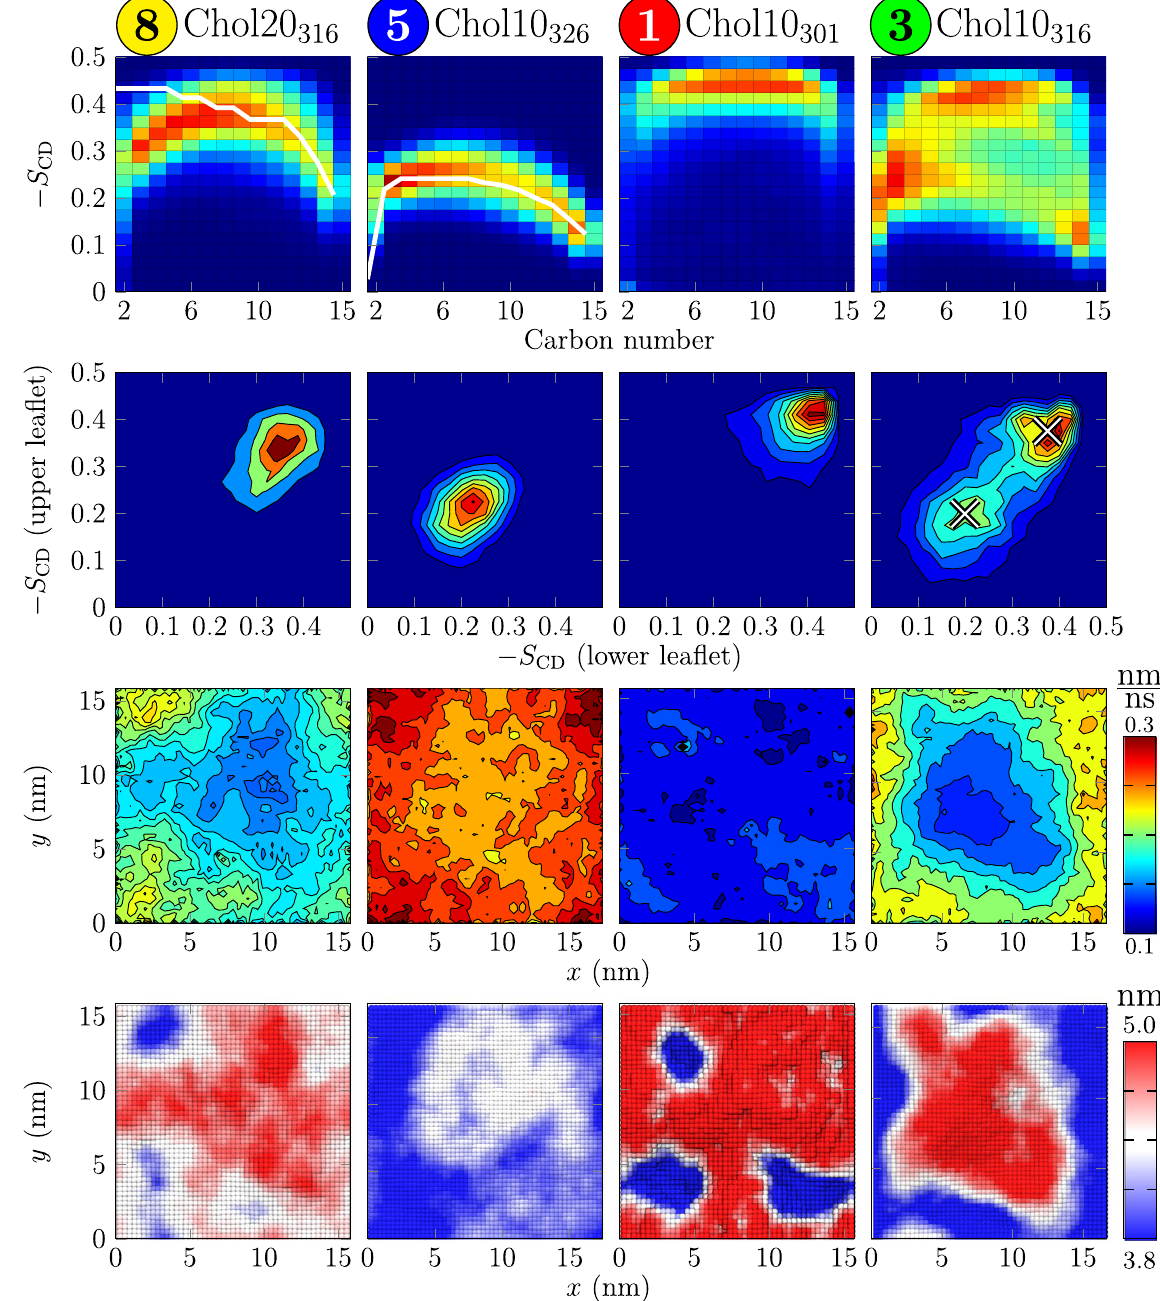
Figure 2. Results shown for systems labelled by the points in the phase diagram (Fig. 1): (8) Chol20 316 (L o phase), (5) Chol10 are shown in white (full line): For the Chol20 316 system (8), given here are the data measured for the L o phase (DPPC + 40 mol-% cholesterol at 308 K) 51 . For the Chol10 326 system (5), the experimental data are for the L d phase system (pure DPPC at 314 K) 52 . Second row: The spatial correlation of lipid chain order ( sn -2 chain of DPPC) between the leaflets. Third row: In-plane lipid displacement map. Fourth row: Thickness